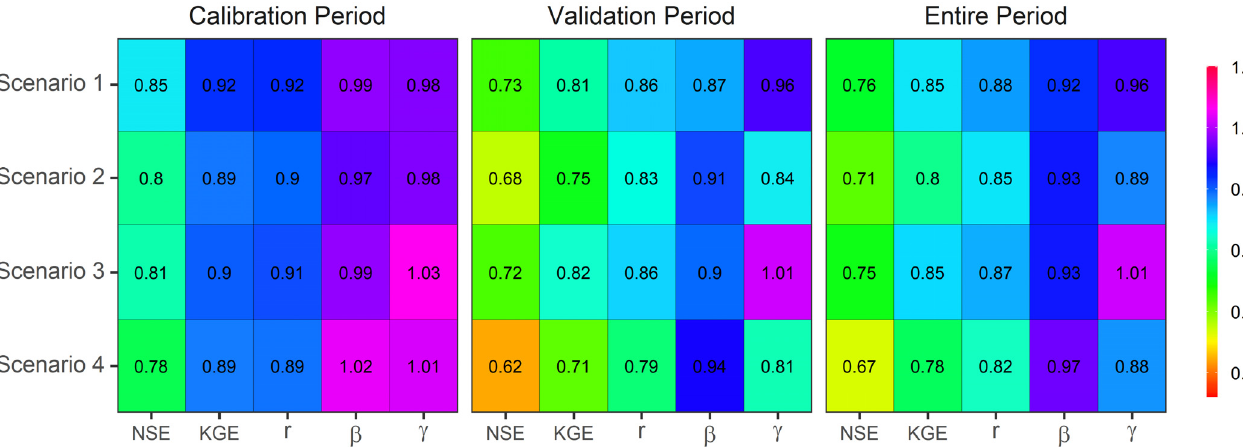
Figure 8. Performance of observed and MSWXv100 datasets in generating daily streamflow simu- lation for the calibration (2015–2016), validation (2017–2019), and entire (2015–2019) periods under four model calibration scenarios.